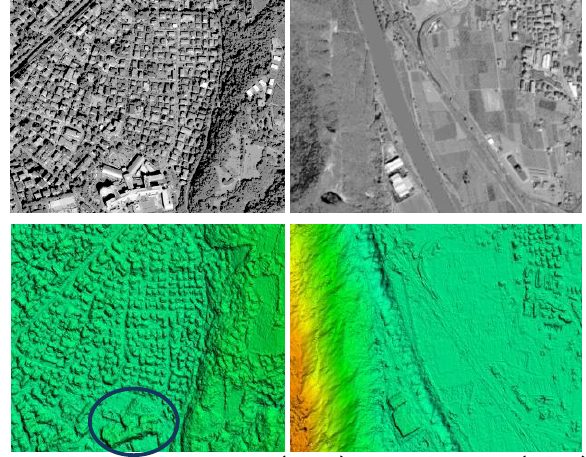
Fig. 6. Zoom in the images (above) and in the DSM (below) over city center (left, with a large building highlighted in blue) and rural areas (right).